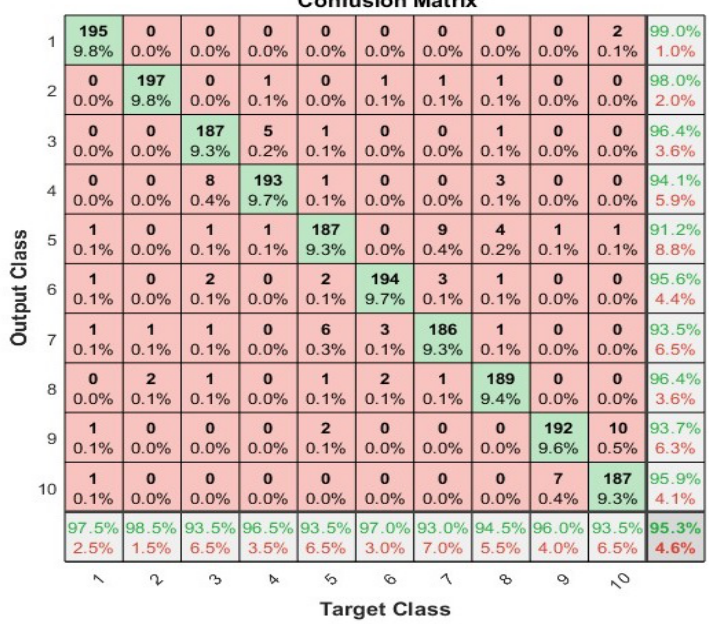
Figure 7. Confusion matrix of neural networks using activation function